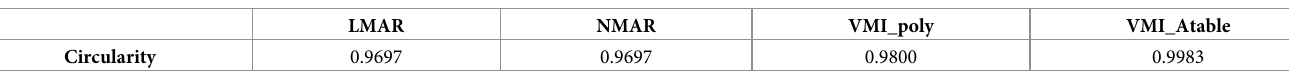
Table 4. The circularity of the copper rod in the CT images obtained the different MAR